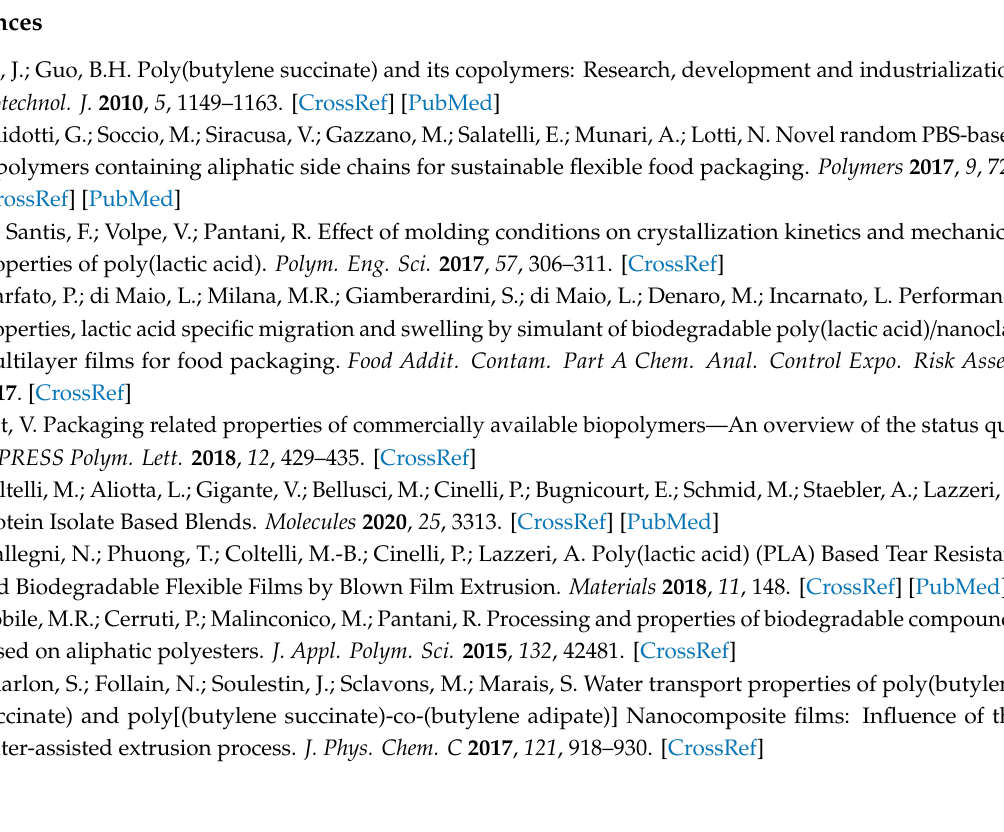
Figure S1: Oscillatory shear measurements in the frequency domain carried out at 160 ◦ C on: (a) PBS, (b) PBAT, Figure S2: DSC crystallization peak deconvolution of PBS50-PBAT50 blend highlighting the PBS (green curve) and PBAT (blue curve) cooling crystallization peaks, Figure S3: Illustrative stress-strain curves of films based on neat PBS, PBAT, and their